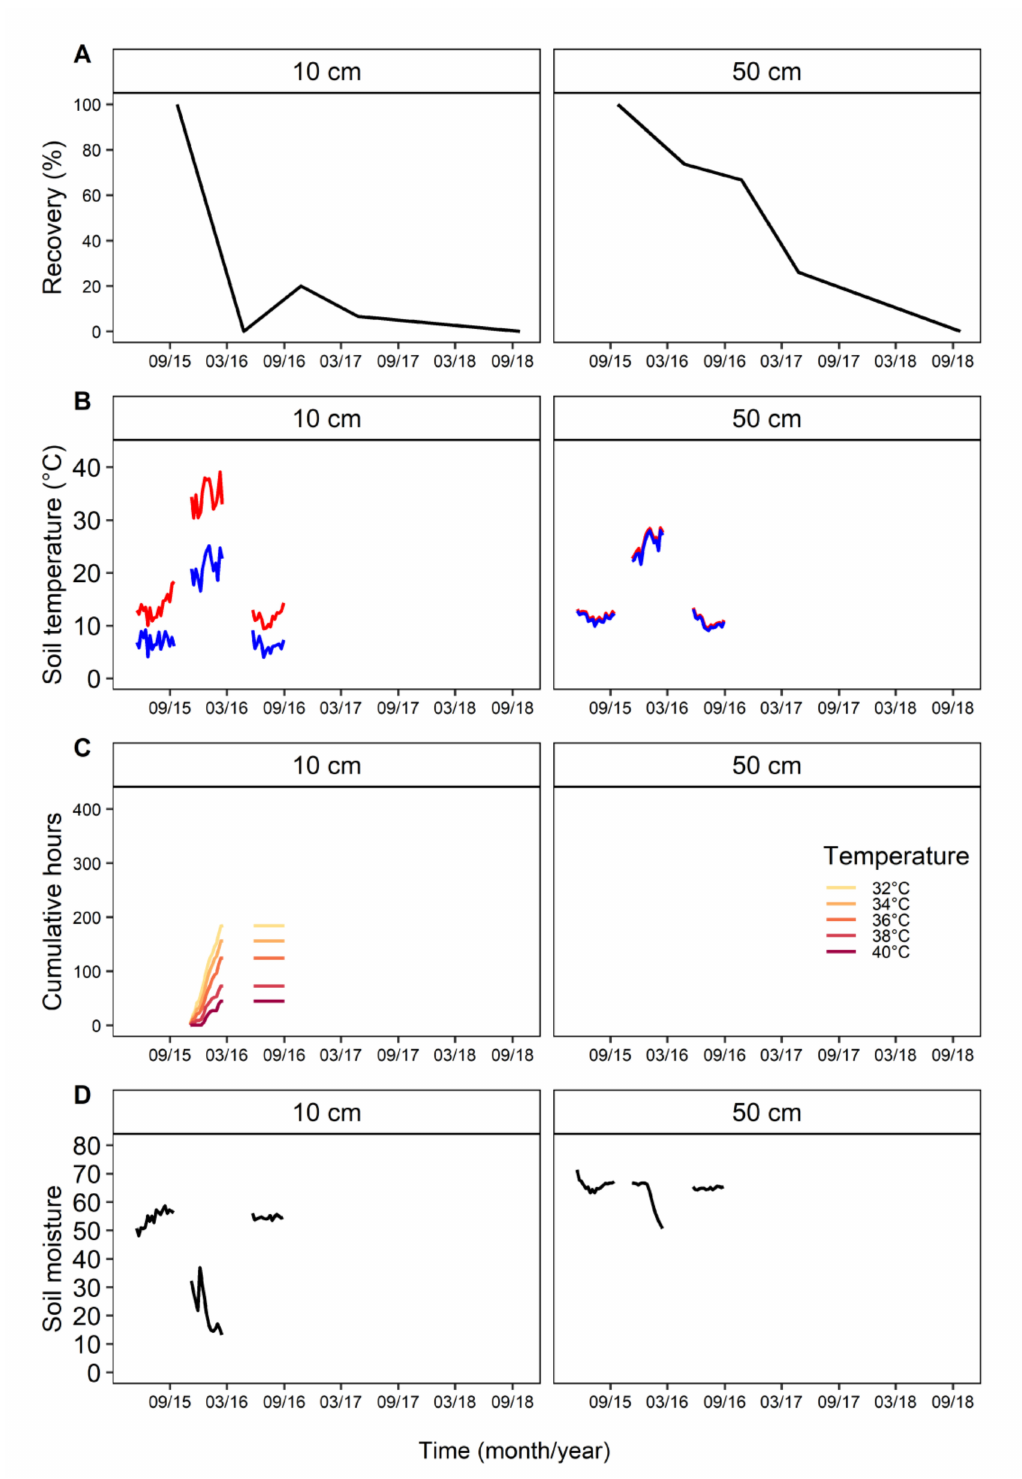
Figure 6. ( A ) Recovery of Phytophthora cinnamomi from Redwood stockpile at 10 and 50 cm depth in relation to ( B ) soil temperatures, ( C ) cumulative number of hours of soil temperatures above 32 ◦ C, and ( D ) soil moisture (%). Gaps in temperature and moisture represent missing